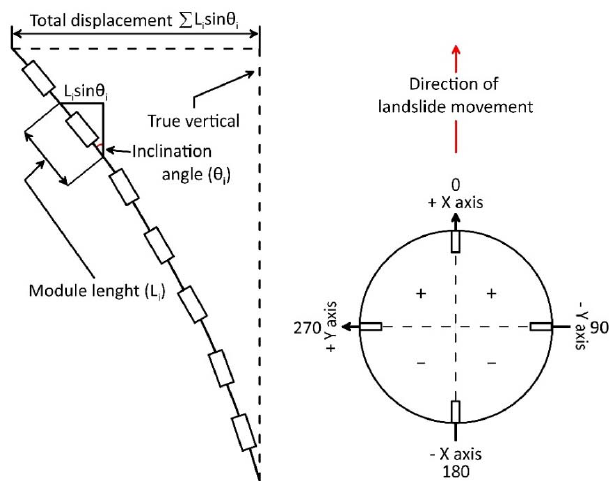
Figure 10. Calculation scheme for a multi ‐ module inclinometer (modified from [41]).